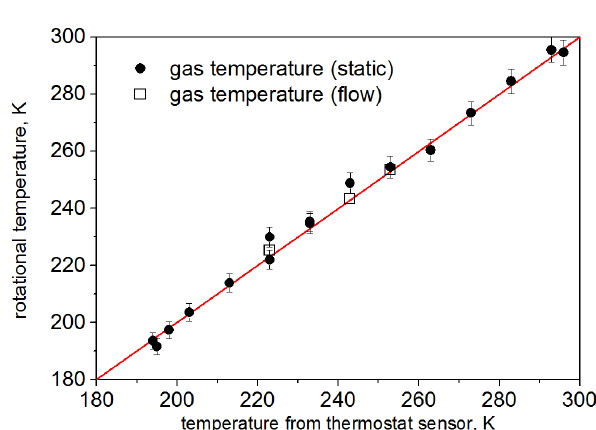
Fig. 1. Correlation between the rotational temperature derived from the oxygen A-band and the temperature obtained using cryostat sen- sor (symbols).